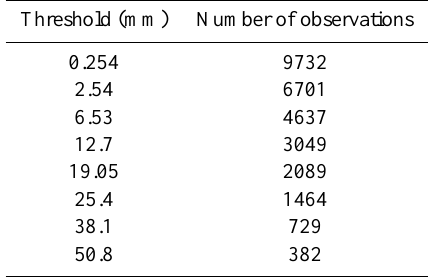
Figure 13: Equitable Threat Score (ETS) and BIAS score (BIAS) for the different runs averaged over the domain and displayed with respect to threshold.